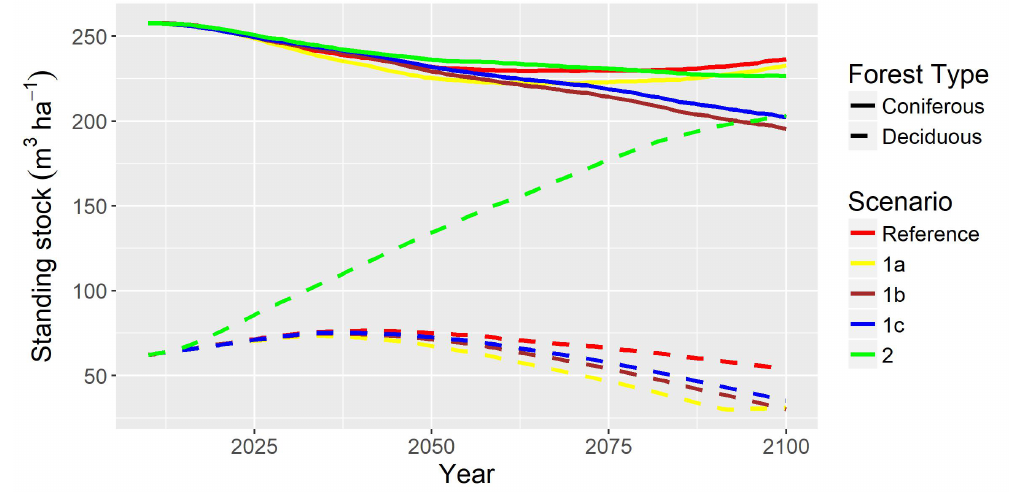
Figure 2. Development of the stem wood volume in different forest management scenarios separated by coniferous and deciduous